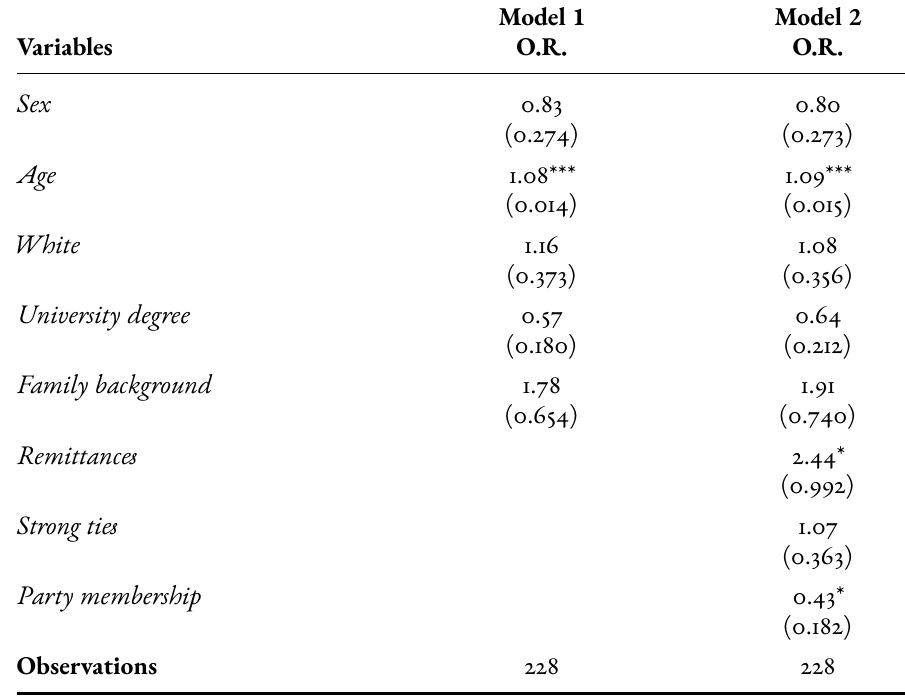
Table 1. Logistic Regressions Models Predicting Being a Cuentapropista Standard errors in